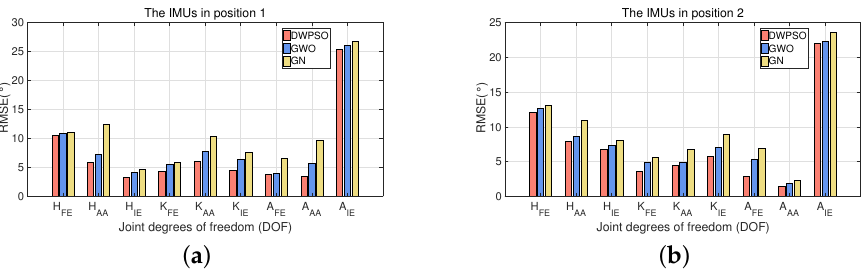
Figure 10. The RMSE ( ◦ ) comparison of three algorithms when IMUs on subject 2 were bound in two positions. ( a ) The IMUs in position 1; ( b ) the IMUs in position 2. The IMUs in position 1